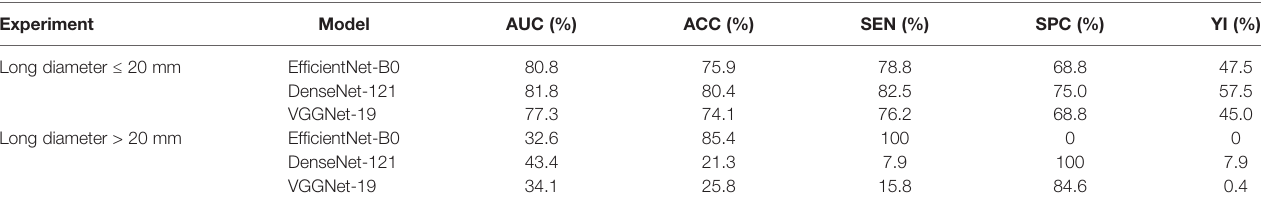
TABLE 6 | Diagnostic performance of deep convolutional neural network model for differentiating luminal A and non-luminal A subtypes based on tumor sizes in the main cohort. Experiment